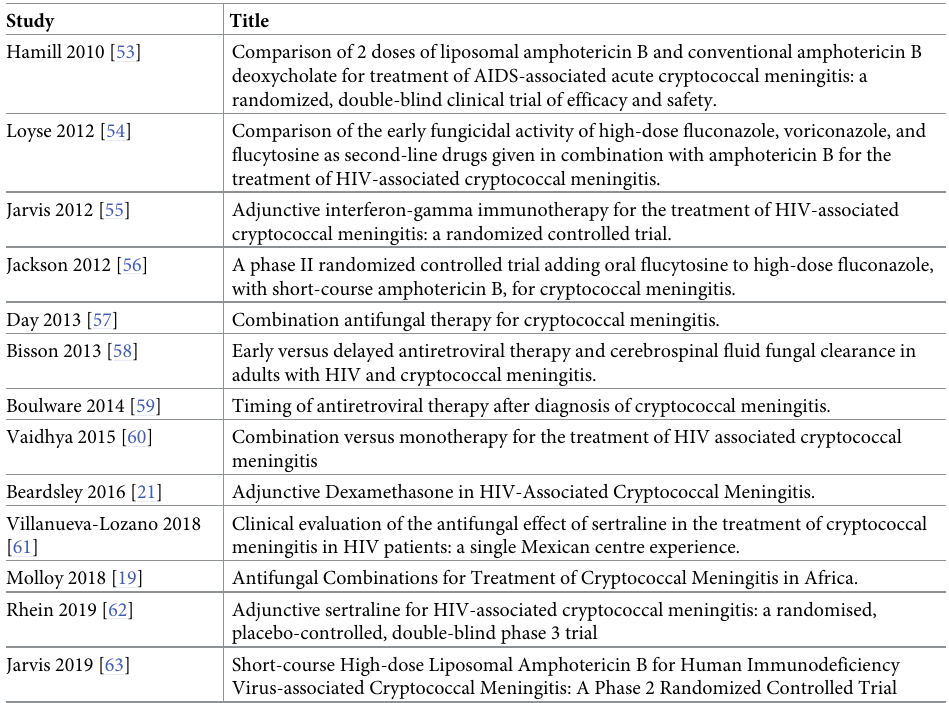
Hamill 2010 [53] Comparison of 2 doses of liposomal amphotericin B and conventional amphotericin B deoxycholate for treatment of AIDS-associated acute cryptococcal meningitis: a randomized, double-blind clinical trial of efficacy and safety. Loyse 2012 [54] Comparison of the early fungicidal activity of high-dose fluconazole, voriconazole, and flucytosine as second-line drugs given in combination with amphotericin B for the treatment of HIV-associated cryptococcal meningitis. Jarvis 2012